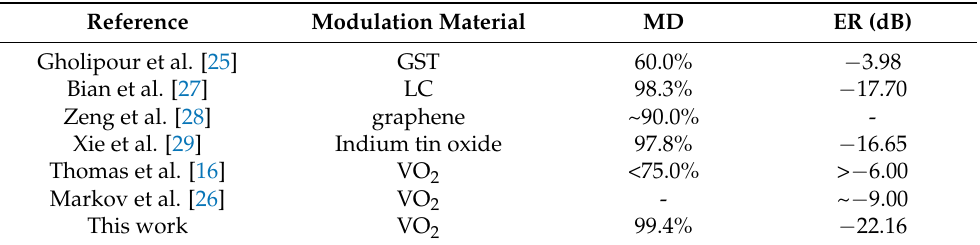
Table 2. Comparison of modulation performances between this work and previous works.